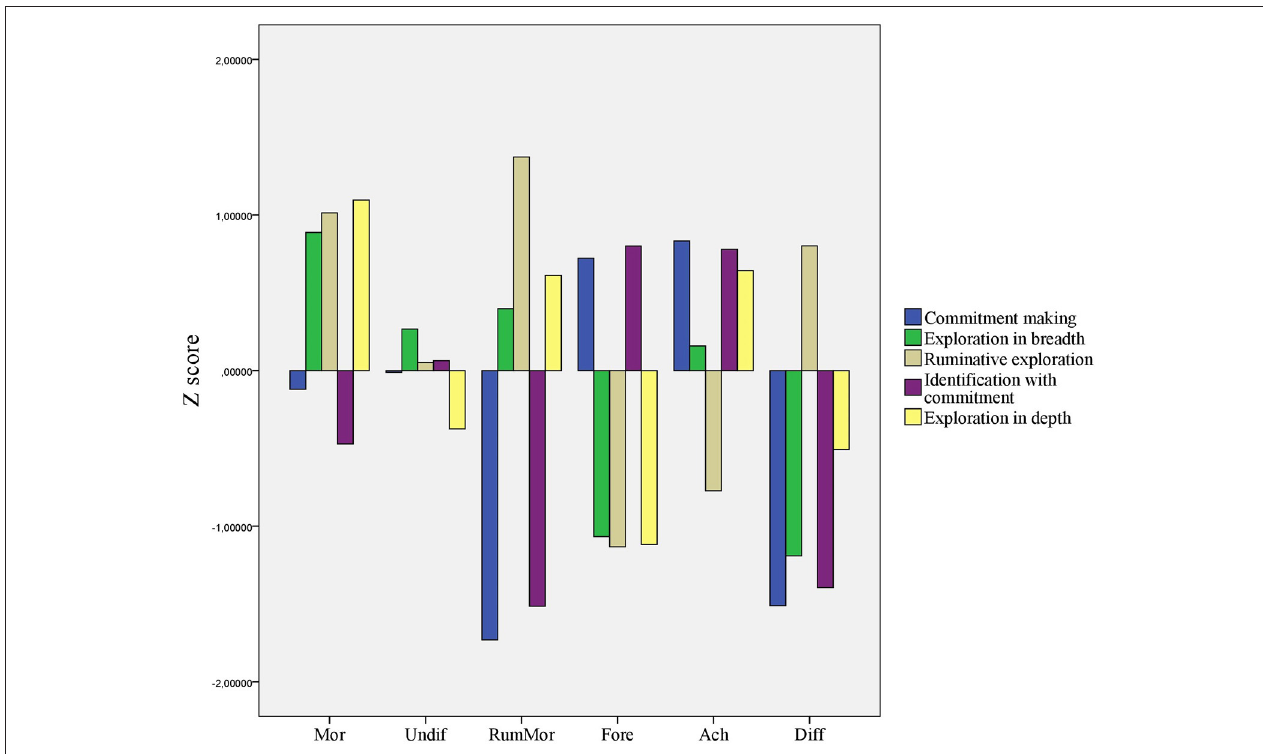
FIGURE 1 | Six clusters based on the Z- scores of the five dimensions of H-DIDS; results of k-means clustering. Mor, Moratorium cluster; Undif, Undifferentiated cluster; RumMor, Ruminative Moratorium cluster; Fore, Foreclosure cluster; Ach, Achievement cluster; Diff, Diffusion cluster.